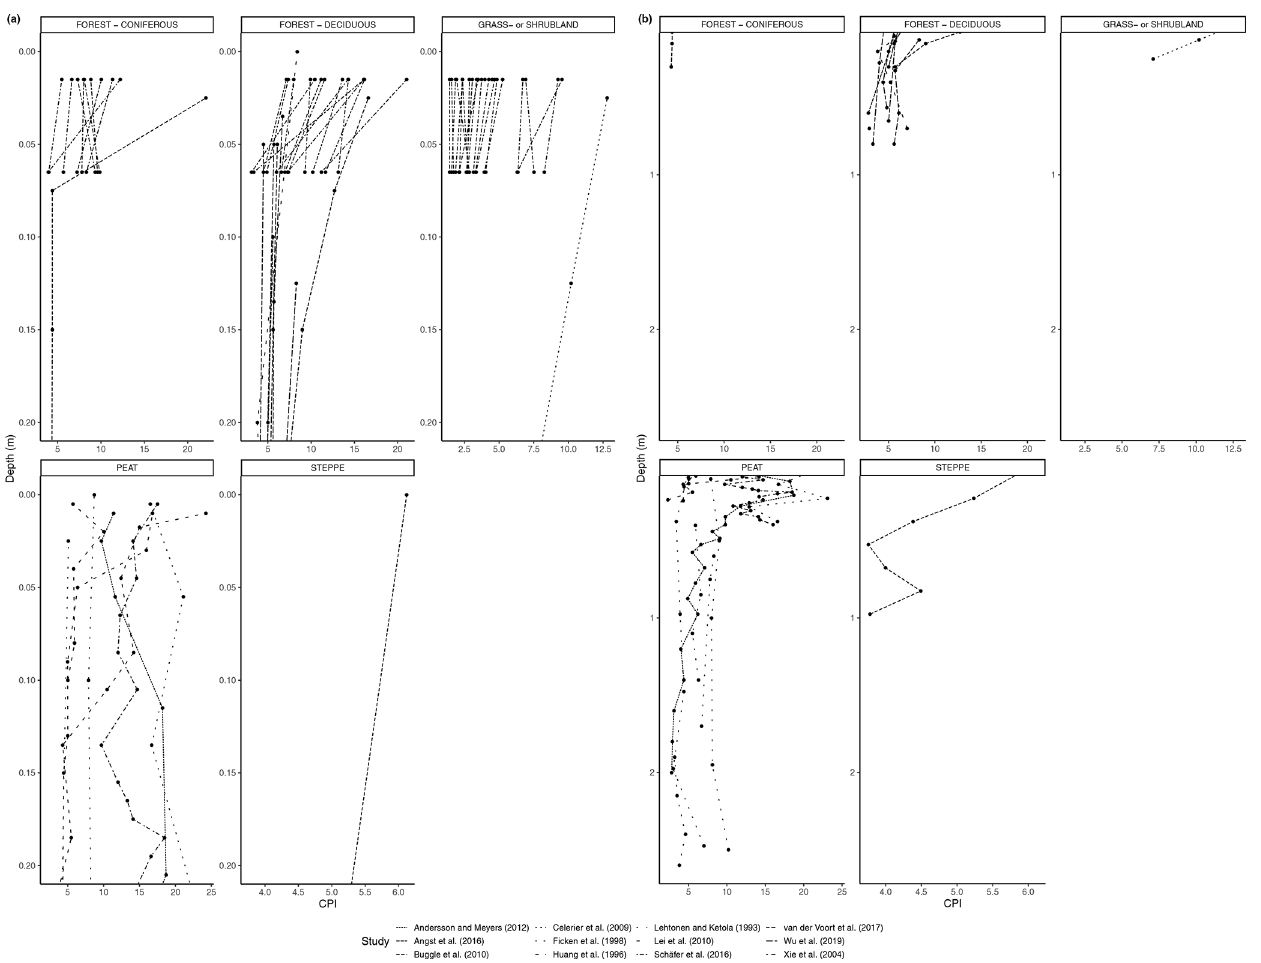
Figure 8. (a) CPI of n -alkanes in soil from 0 to 20cm. (b) CPI of n -alkanes in soil below 20cm.